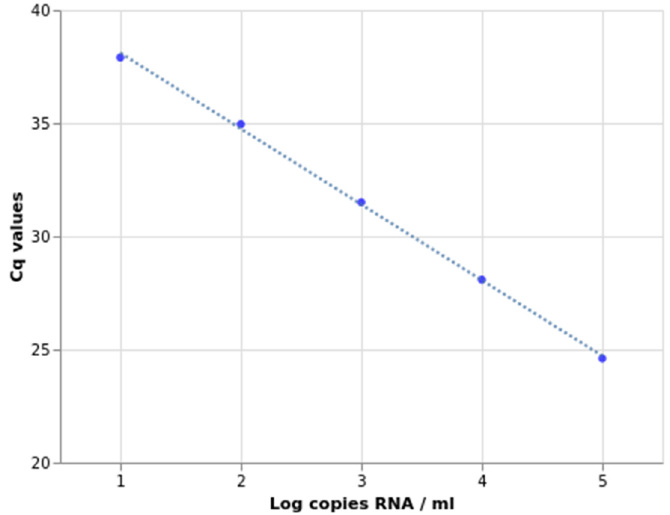
Figure A2. The effectiveness of the Ins214EPE RT-qPCR is 99%. The slope of the standard curve is − 3.34.